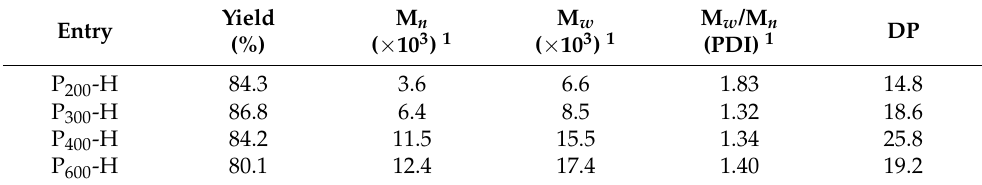
Table 1. Characteristics of poly(oxyethylene H-phosphonate)s